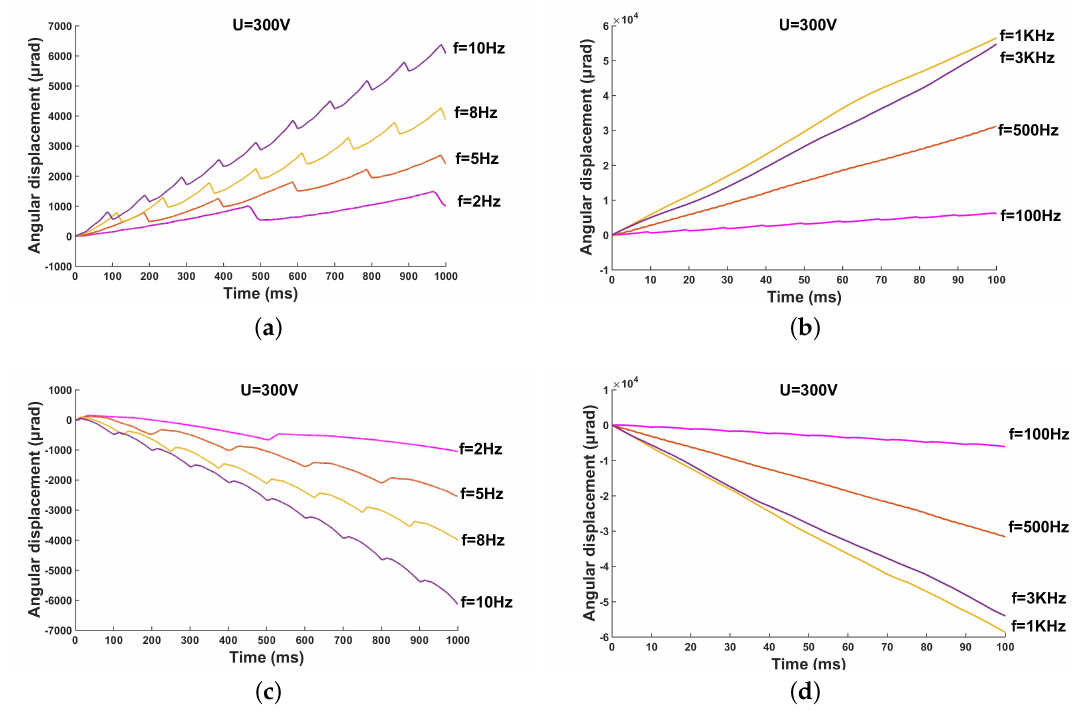
Figure 12. Angular displacement under various driving frequencies: ( a ) low frequency, clockwise rotation; ( b ) high frequency, clockwise rotation; ( c ) low frequency, counterclockwise rotation; and ( d ) high frequency, counterclockwise rotation.